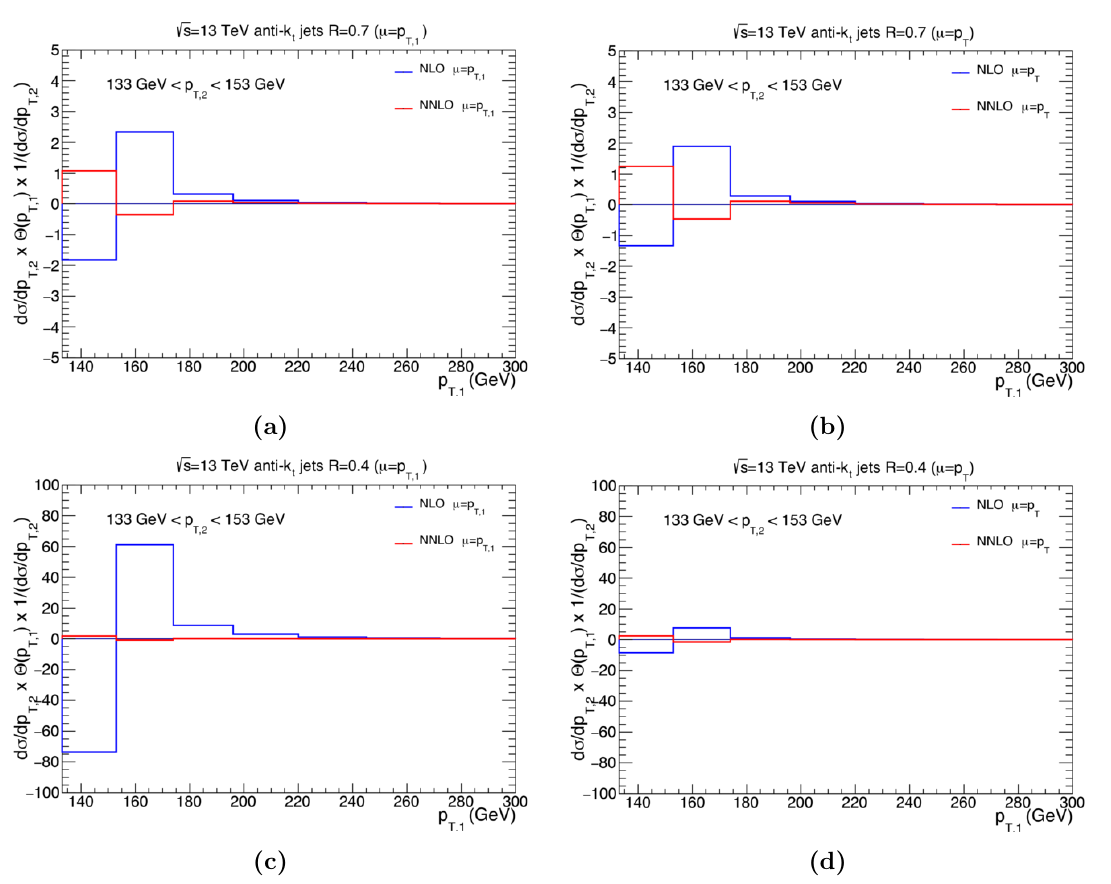
Figure 11 . Decomposition of events contributing to a single bin in p T ; 2 according to the transverse momentum of the leading jet in the event p T ; 1 . CMS cuts at 13 TeV with jet resolution R = 0 : 7 and scale choice (a) (cid:22) = p T ; 1 ; (b) (cid:22) = p T ; jet resolution R = 0 : 4 and scale choice (c) (cid:22) = p T ; 1 ; (d) (cid:22) = p T